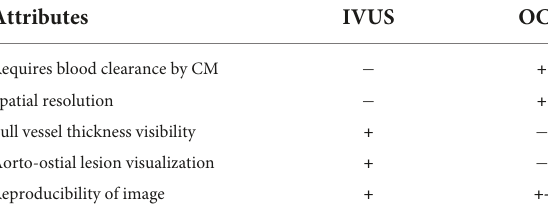
TABLE 10 Comparison of IVUS and OCT applicability and